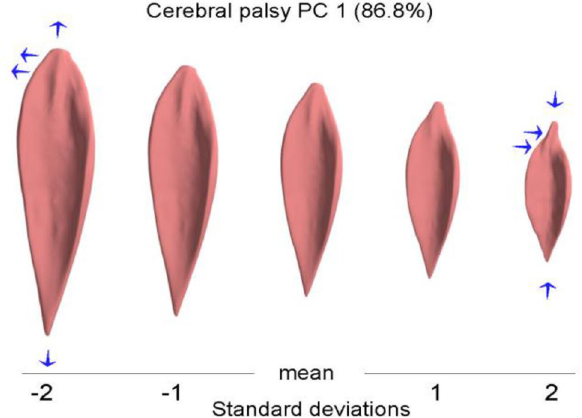
Figure 3. The variation of the CP soleus muscle along the first principal component (size). The blue arrows indicate the change of the muscle shape. The principal component can be described physically as the combination of two features: variation in overall size and a change of the muscle width at its proximal extremity.